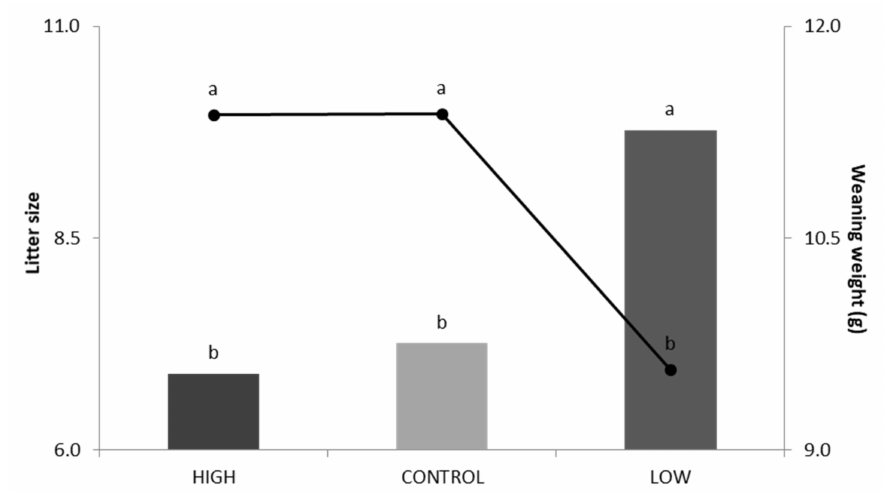
Figure 3. Litter size at weaning (in bars) and weaning weight (line) for the high line, control line, and low line. Di ff erent letters a,b,c show statistically significant di ff erences ( p < 0.05).